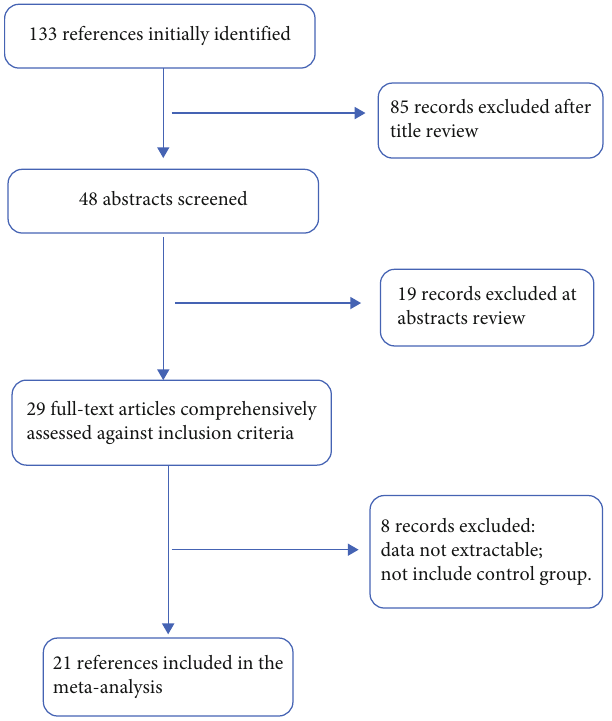
Figure 1: Flow chart of literature